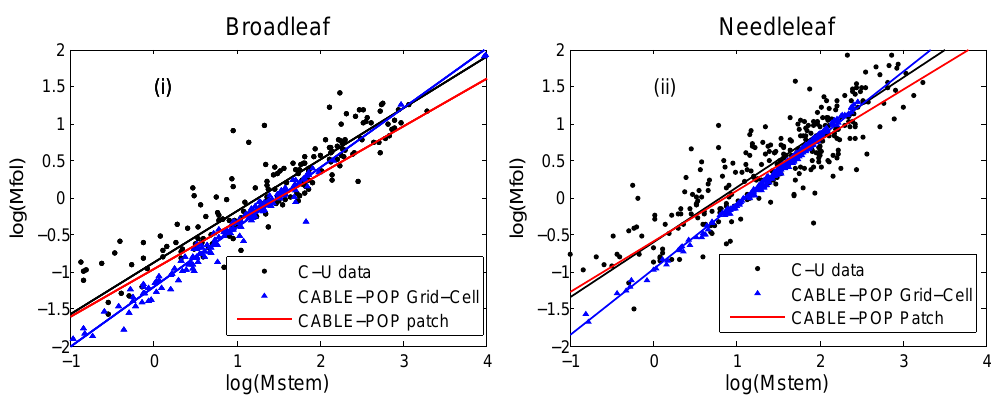
Figure 7. Leaf–Stem allometry plots for (i) broadleaf and (ii) needleleaf PFTs. C–U data and CABLE-POP patch results are the same as in Fig. 3 (iii) and (iv) . CABLE-POP grid-cell results are from deducing stem density from total grid-cell biomass (average over multiple patches, weighted by probability of time since last disturbance with a mean disturbance interval of 100 year) via Eq. (8), and using this to compute M fol and M stem from grid-cell foliage and stem biomass